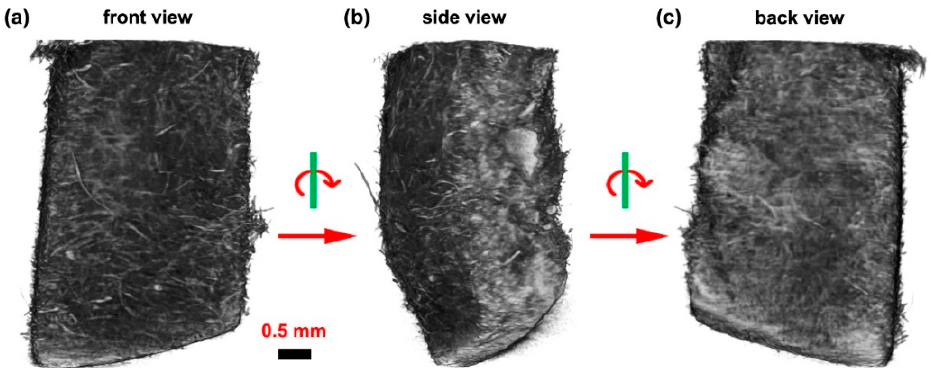
Figure 4. The 3D morphology of the yttria-stabilized ZrO 2 fiber insulation tile at three orthometric viewpoints. The sample was rotated along the axis in green: ( a ) front view, ( b ) side view, and ( c ) back view.